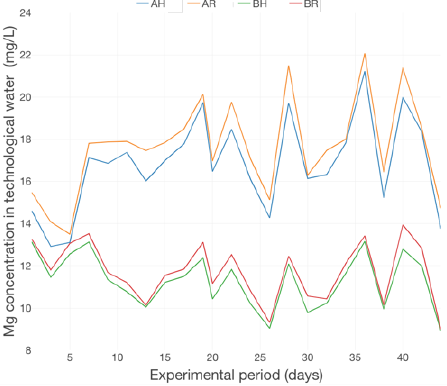
Figure 23. The dynamics of Ca concentration in technological water for each of the experimental variants.